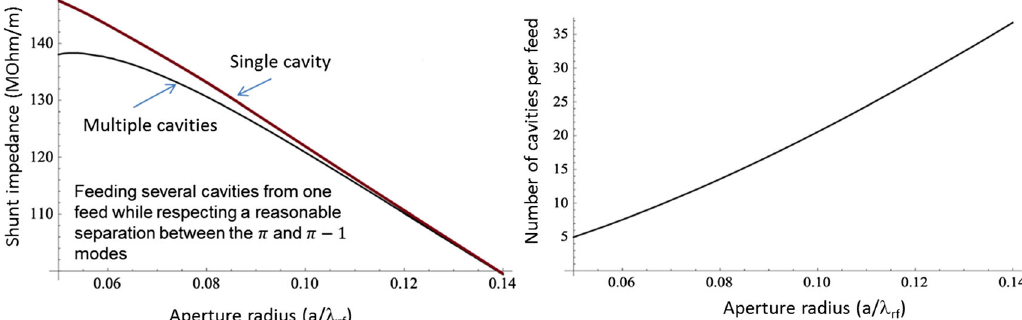
FIG. 21. Aperture constraints for feeding more than one cavity at a time. (Left) Comparison between shunt impedance for an optimization done on a single cavity and an optimization done on a set of cavities with adequate spacing between the π mode and the nearest neighbor mode. (Right) The number of cavities allowed for the given coupling due to the aperture after the optimization.